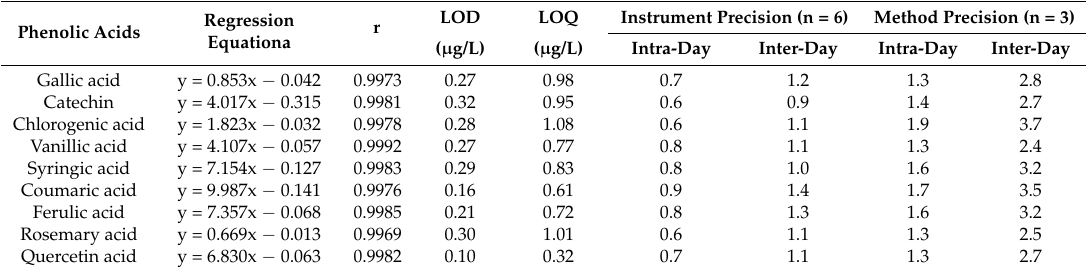
Table 2. Linear regression equation, correlation coefficients, LODs, LOQs, reproducibility of retention time and peak area, intra ‐ and inter ‐ day precisions.